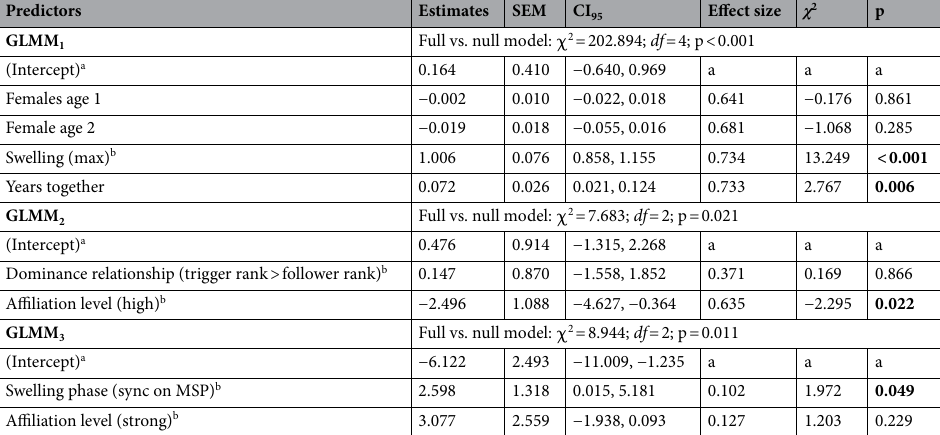
Table 2. Full results of: GLMM 1 on factors that could influence swelling synchronization (N cases = 5256); GLMM 2 on factors that could elicit swelling synchronization on MSP (N cases = 52); and GLMM 3 to check if females socio-sexual contacts were influenced by synchronization on MSP and/or by affiliation levels (N = 153). For all models dyad identity and Julian date were included as random factors. Significant values are in bold. a Not shown as not having a meaningful interpretation. b These predictors were dummy-coded, with